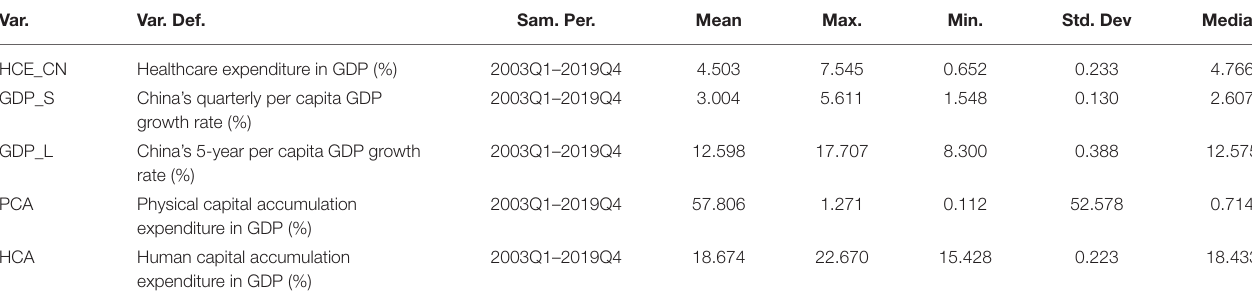
TABLE 1 | Statistical description of the main variables in the article. Var. Var. Def. Sam. Per.